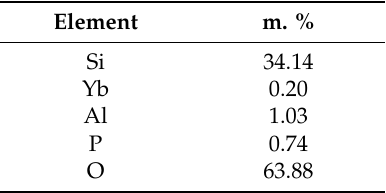
Table 4. EDX measurement: Element doping ratio in atomic percentage (excluding oxygen). Element